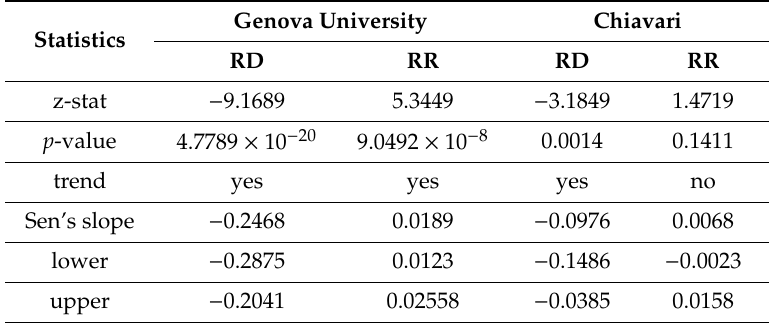
Table 6. Mann-Kendall trend test results at 95% confidence for rainfall rate (RR) and rainy days (RD) series at Genoa University (1833–2019) and Chiavari (1877–2019) rain gauges.